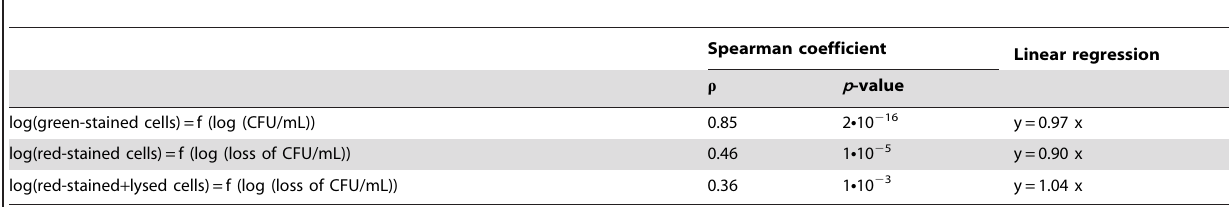
Table 2. Statistical correlations between the stained cells counted by flow cytometry and the cultivable cells determined by plate